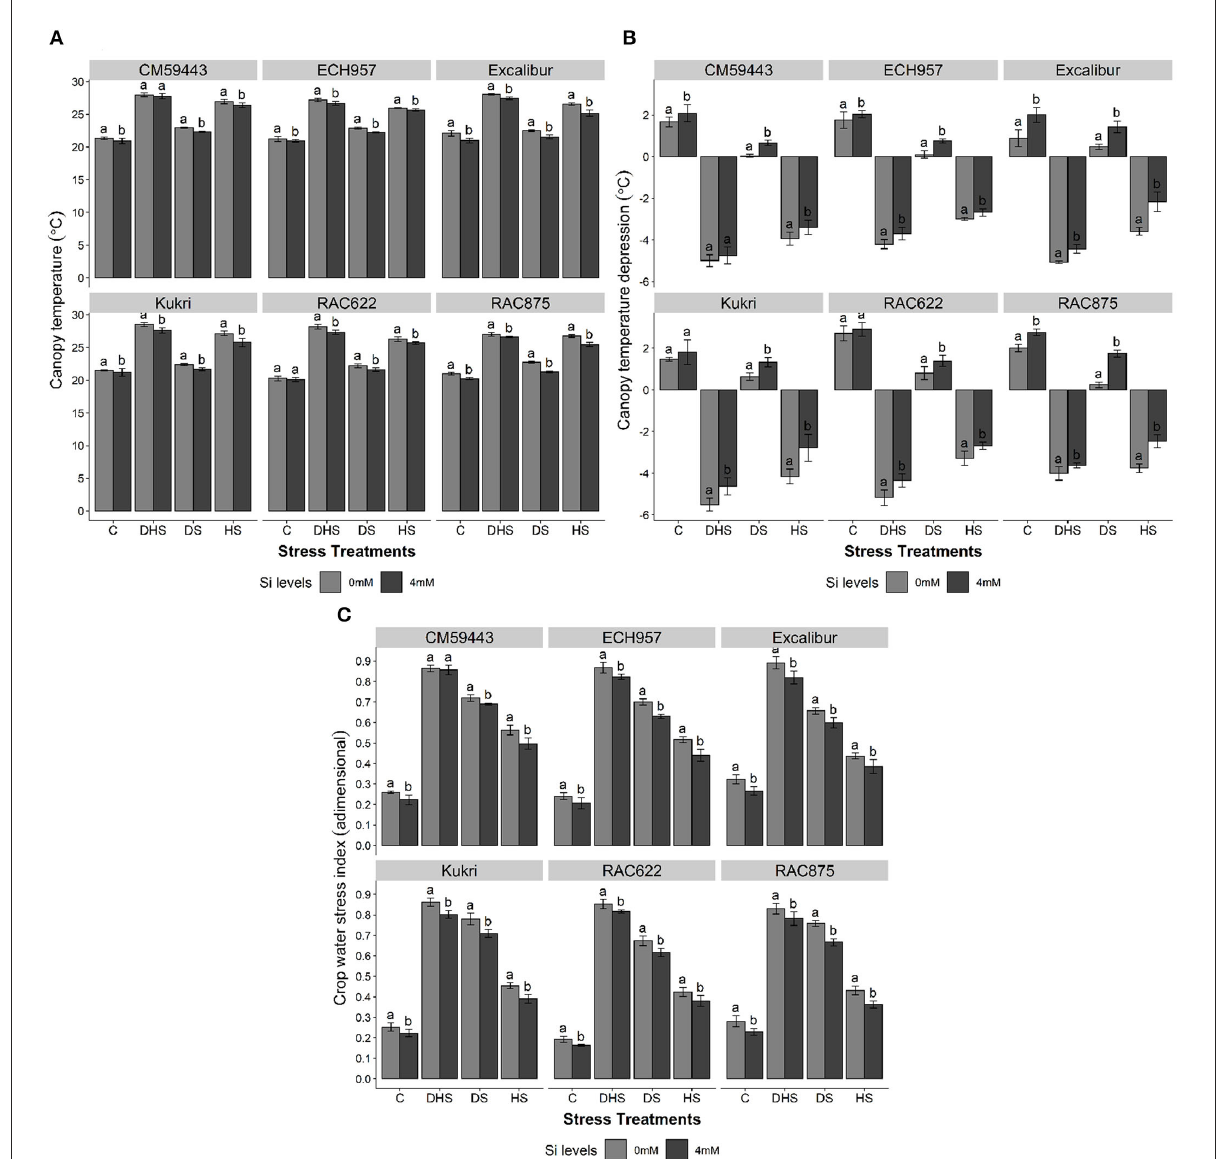
FIGURE3 Effect of silicon on (A) plant’s canopy temperature ( ◦ C), (B) canopy temperature depression ( ◦ C), and (C) crop water stress index (adimensional) of six contrasting wheat cultivars under terminal drought, heat and drought-heat combined stress in controlled glasshouse conditions. Mean values are presented with ± SE, represented with error bars. Different letters indicate statistical significance within each cultivar at p < 0.05.